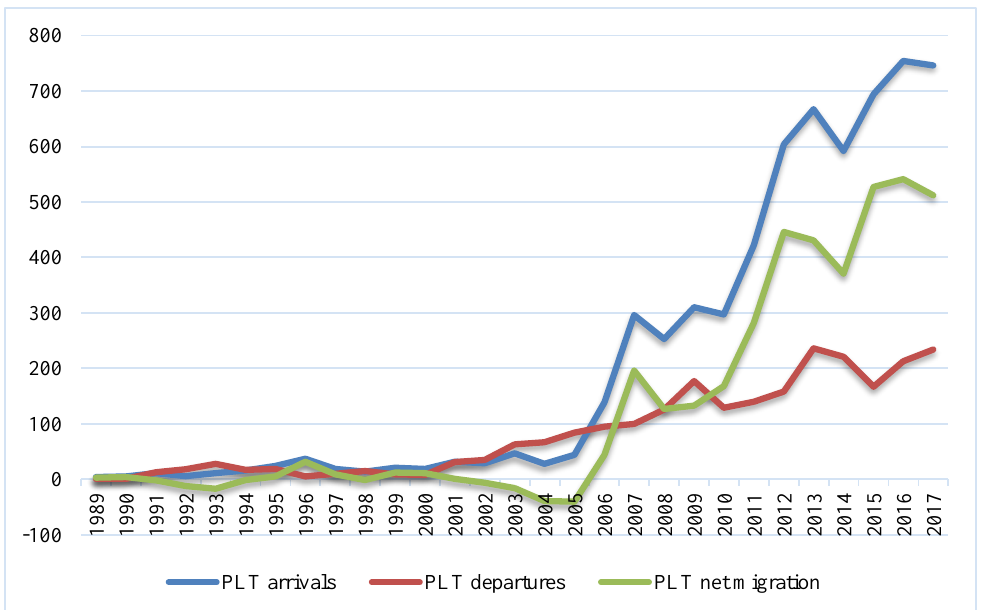
Figure 2. PLT migration to New Zealand from Czechia 1989–2017 (March